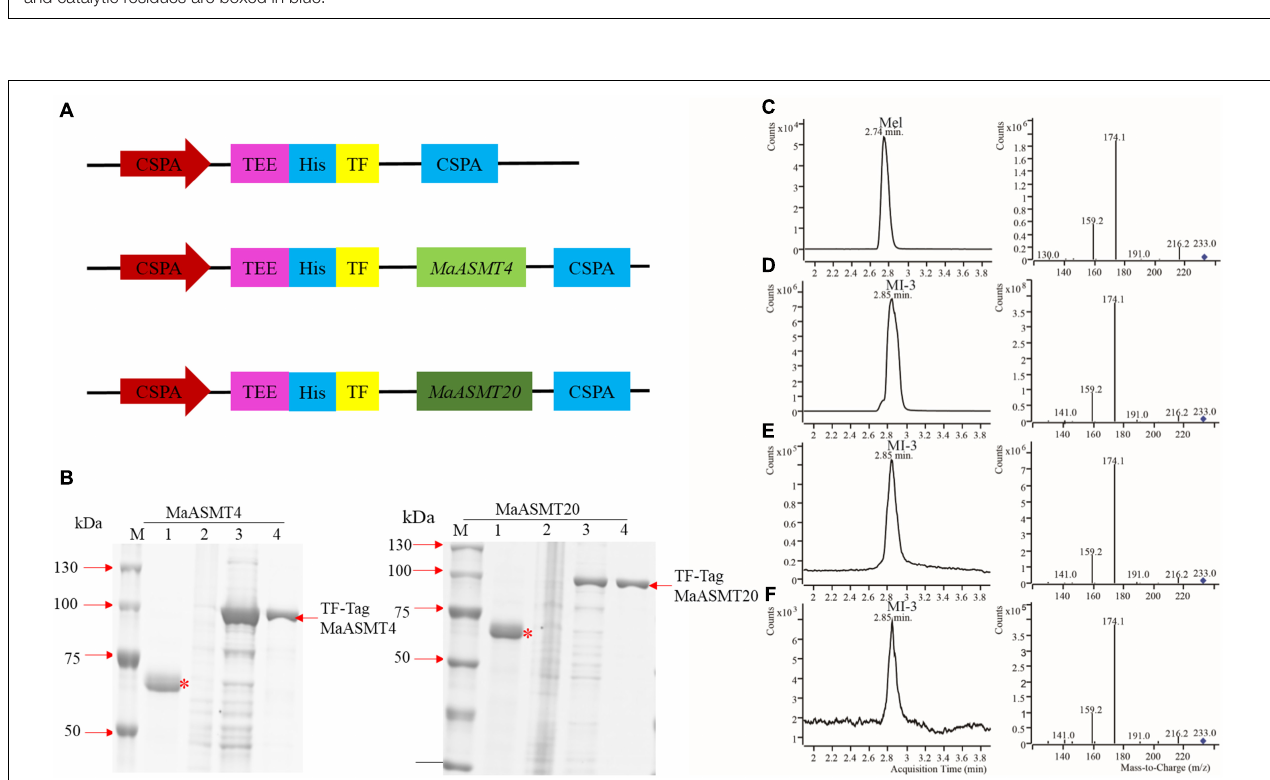
FIGURE 5 | Expression and activity analyses of MaASMT4 and MaASMT20 proteins. (A) Schematic diagram of the E. coli expression vector in pCold TF harboring MaASMT4 and MaASMT20 . (B) Purification of N-terminal His × 6-tagged MaASMT4 and MaASMT20 proteins. E. coli BL21 (DE3) cells harboring either pCold TF- MaASMT4 or pCold TF- MaASMT20 were incubated with IPTG for 8 h at 28 ◦ C. Lane 1: protein marker; lane 2: pCold TF (+ IPTG); lane 3: recombinant (–IPTG) lane 4: recombinant (+ IPTG); lane 5: purified protein. “TF” is Trigger Factor, a prokaryotic ribosome-related molecular chaperone that facilitates the translation and folding of peptides. “ ∗ ” indicates the Trigger factor protein. “–IPTG” indicates no addition of 1 mM IPTG to the E. coli BL21 (DE3) culture, “+IPTG” indicates addition of 1 mM IPTG to the E. coli BL21 (DE3) culture. Products of in vitro enzymatic reactions detected by UPLC-MS/MS. (C) Melatonin standard; (D) N -acetyl-6-methoxytryptamine standard; (E) Chromatogram of N -acetylserotonin catalyzed by MaASMT4; (F) Chromatogram of N -acetylserotonin catalyzed by MaASMT20.